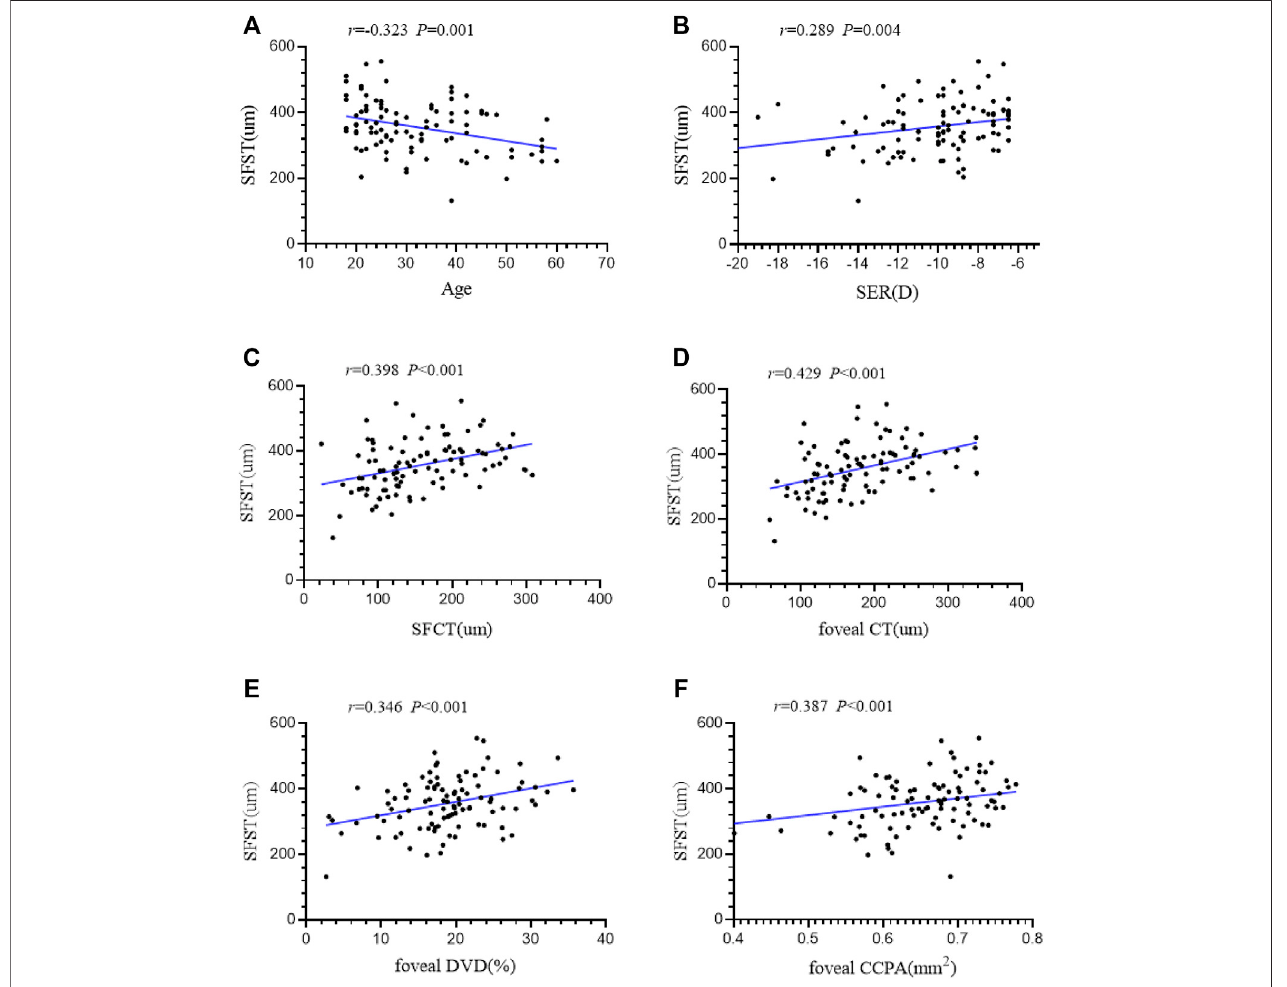
FIGURE4| ( A – F) ThecorrelationbetweenSFSTandage,SER,SFCT,fovealCT,fovealDVDandfovealCCPAin98highmyopiceyesweredemonstrated. AL axial length, SER sphericalequivalentrefraction, SFRT subfovealretinalthickness, SFCT subfovealchoroidthickness, SFST subfovealscleralthickness, SVD super fi cialretinal vascular density, DVD deep retinal vascular density, CCPA choriocapillaris perfusion